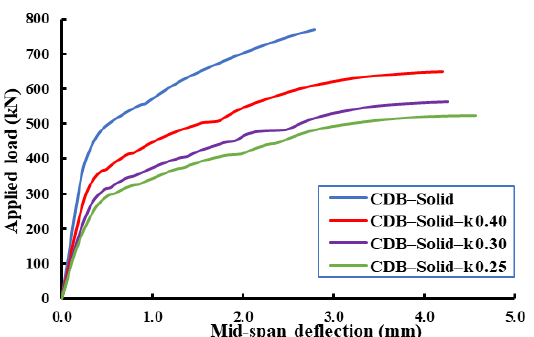
Figure 18. Effect of the load distribution factor on load – mid-span-deflection relationships of RCCDBs without openings (solid).